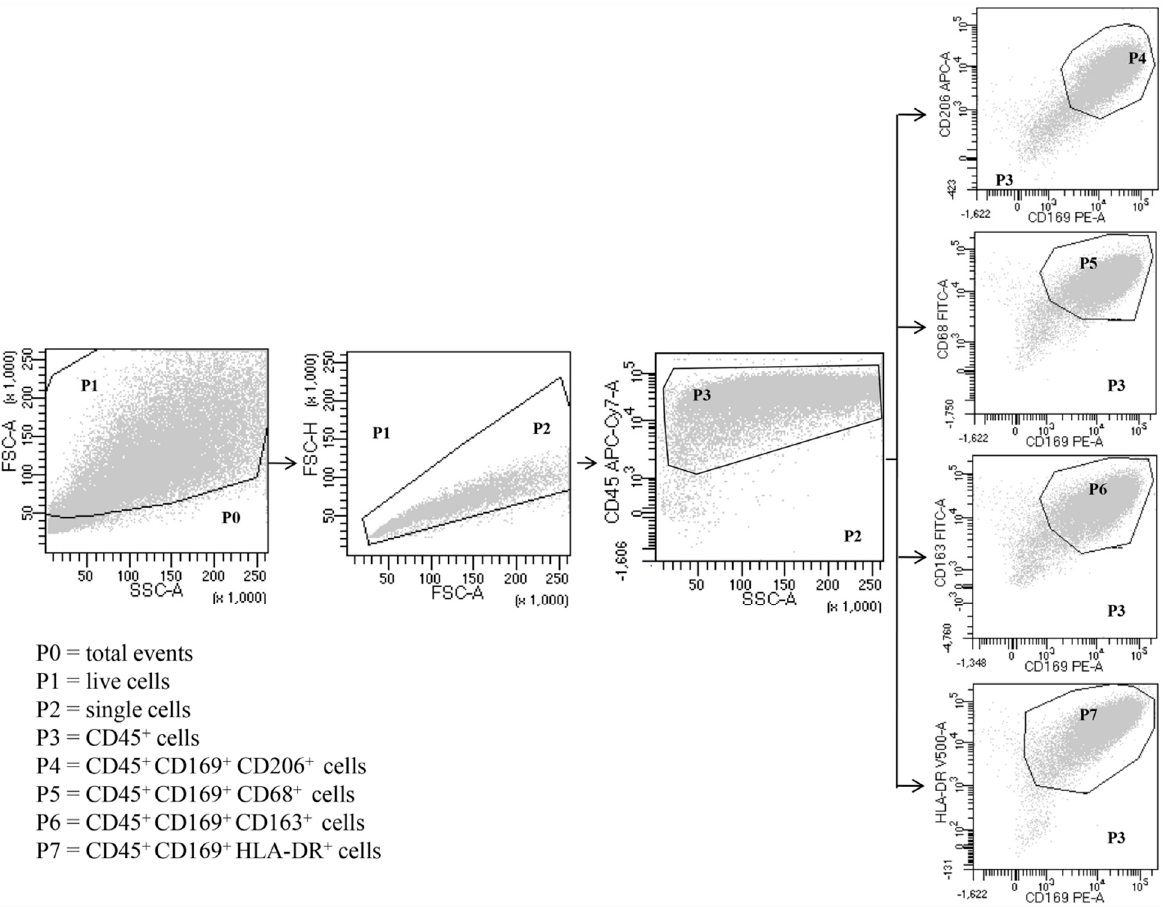
Figure 1. Representative flow cytometric panels with respect to the gating strategy used to identify human lung macrophages. Among total cells (P0), after excluding dead cells (P1) and doublets (P2), leukocytes were identified as CD45 + (P3). Macrophages were identified as SSC high FSC high CD45 + CD169 + (P4-P7) CD206 + (P4) CD68 + (P5) CD163 + (P6) HLA-DR + (P7). Results are representative of three independent experiments.